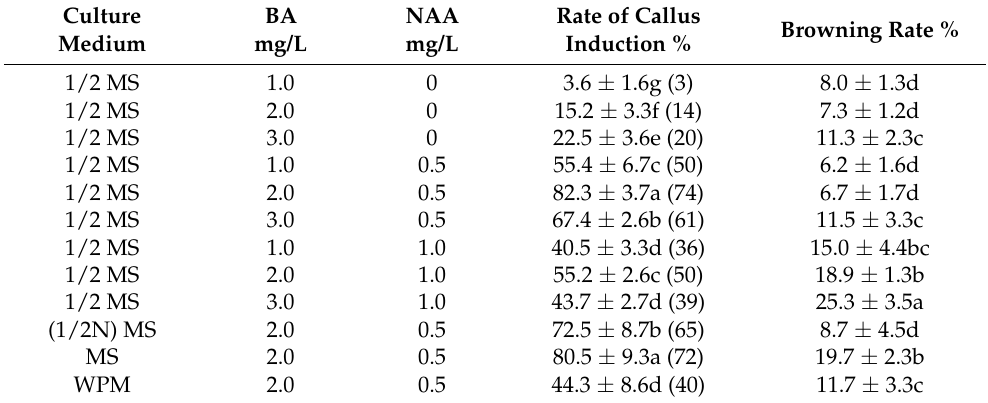
Table 3. Effect of different plant growth regulators and media on callus induction in D. lotus leaf discs.